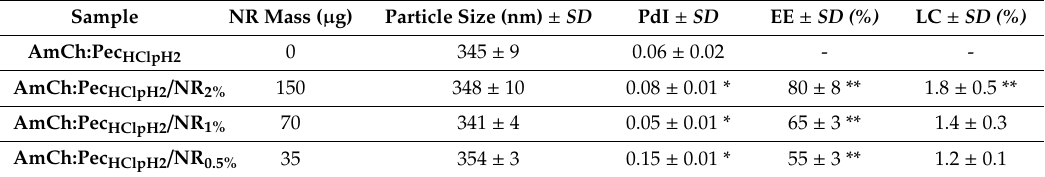
Table 6. Relation mass NR / polymers, mean particle size, and encapsulation parameters of NR-loaded in polyelectrolyte nanoparticles of AmCh:Pec HClpH2